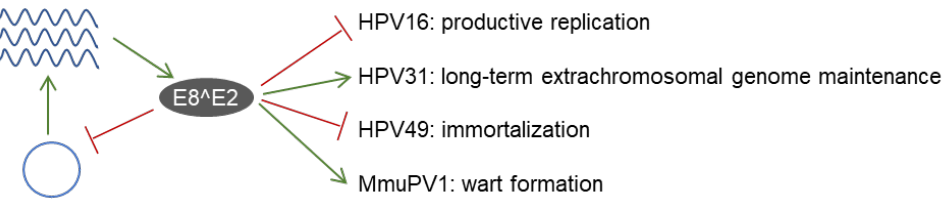
Figure 2. E8^E2 is a conserved repressor of viral replication and gene expression. E8^E2 is expressed from PV genomes and then limits genome replication (blue circle represents the viral genome) and gene expression (viral mRNA is shown as wavy blue lines). E8^E2 expression is required for long-term extrachromosomal maintenance of HPV31 and wart formation by MmuPV1 in vivo. In contrast, E8^E2 restricts productive replication of HPV16 and prevents immortalization of HPV49.